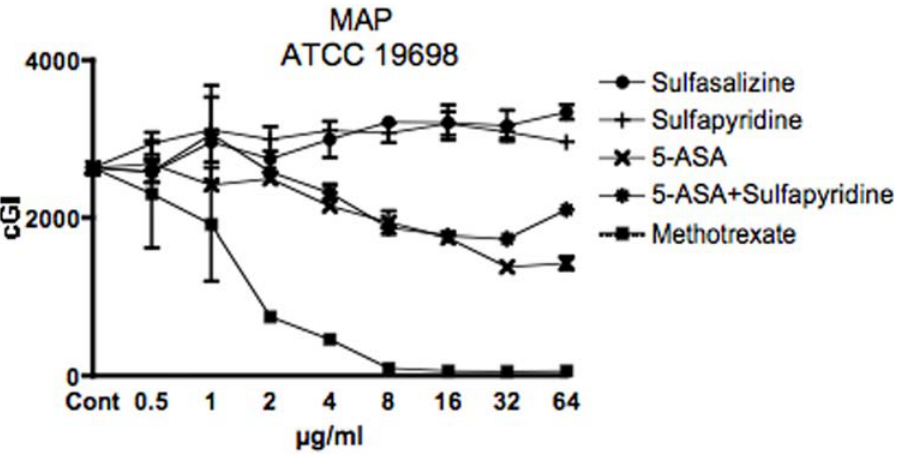
Figure 1. Cumulative GI data when 2.7 6 10 4 CFU/vial of MAP ATCC 19698 was inoculated into each Bactec vial. Each drug dilution was studied in duplicate. Error bars are SD. The positive control is methotrexate, with maximal inhibition by 8 mg/ml. Neither the negative control sulfasalazine, nor sulfapyridine, have any inhibition. Both and 5-ASA alone and in combination with sulfapyridine have dose dependent inhibition.